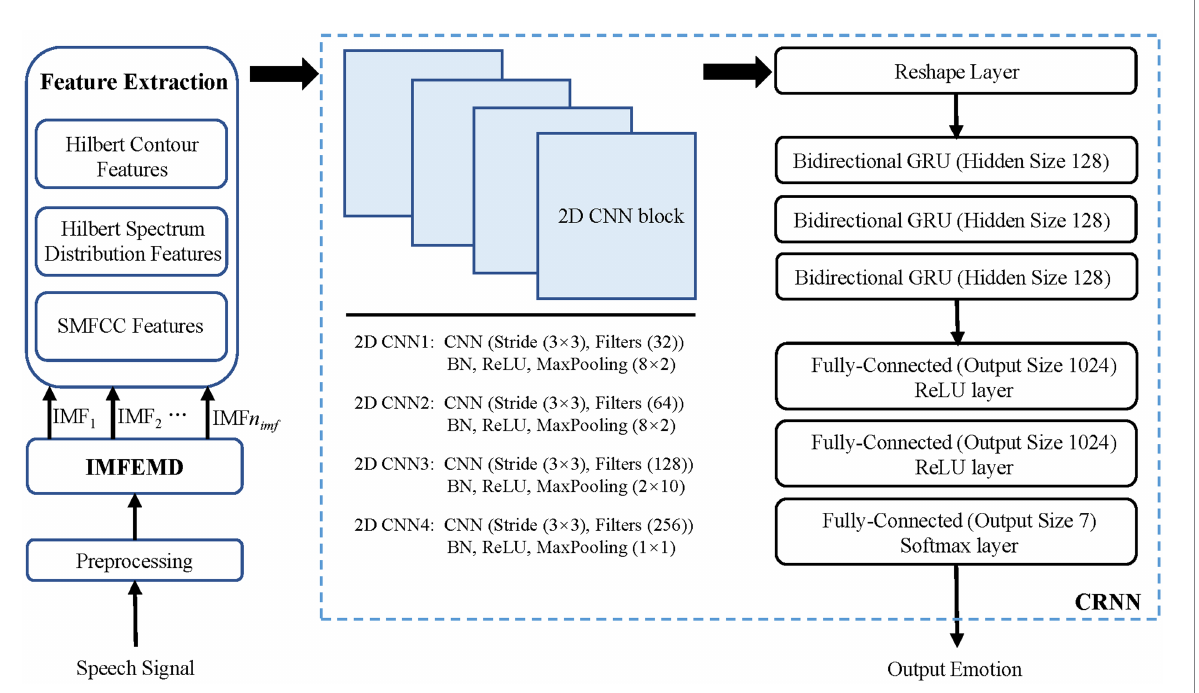
FIGURE 1 Overall scheme of the IMEMD-CRNN. In the figure, every 2D CNN block (2D CNN) has 4 parts: a 2D CNN layer, a batch normalization layer (BN), a ReLU layer (ReLU), and a 2D max pooling layer